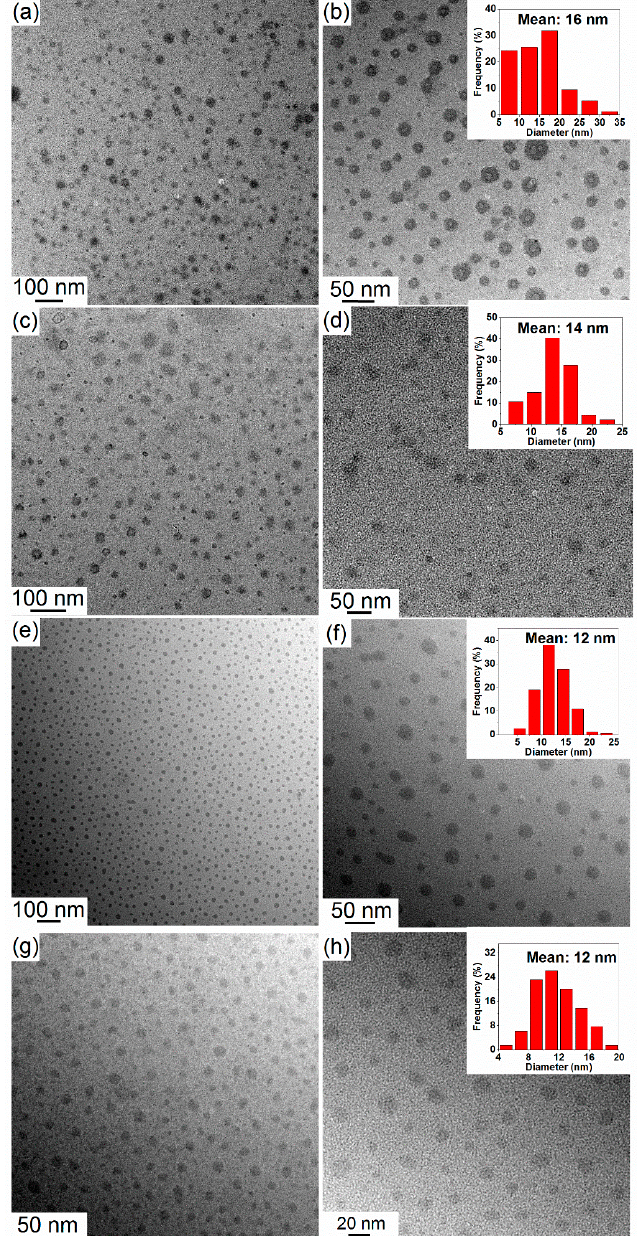
Figure 4. TEM image of the as-synthesized ( a , b ) NaOCH 3 nanoparticles; ( c , d ) NaBH 4 -SUG4.2; ( e , f ) NaBH 4 -SUG8.5; and ( g , h ) NaBH 4 -SUG16.9. The inset diagrams are the corresponding mean particle sizes and size distribution.